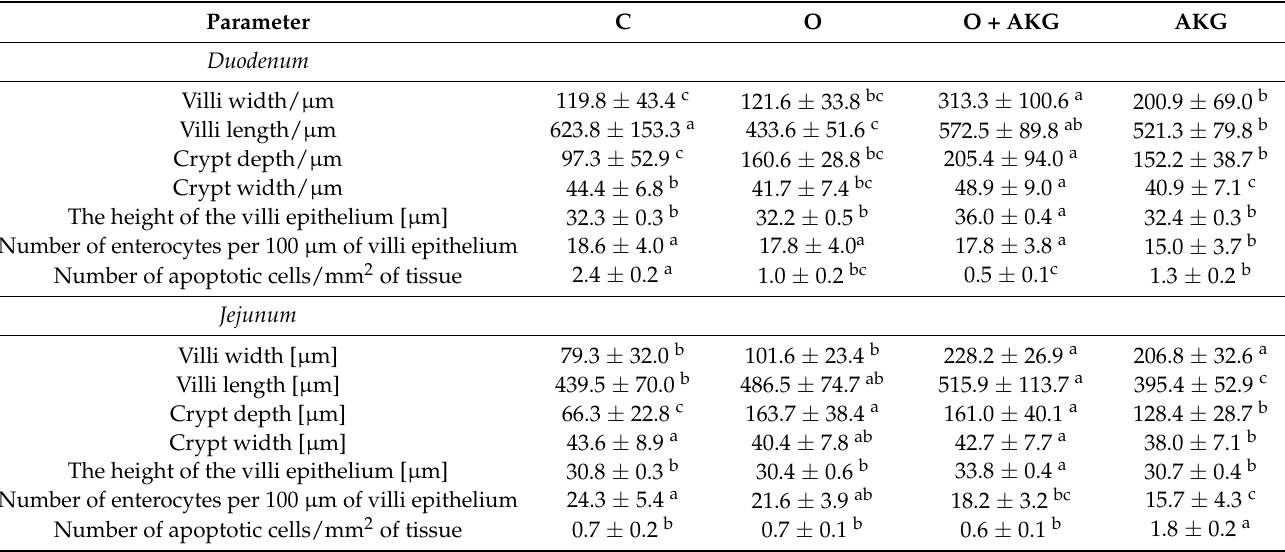
Table 1. Effects of bariatric surgery and alpha-ketoglutarate (AKG) administration on the histological structure of selected parameters of the duodenum and jejunum of the